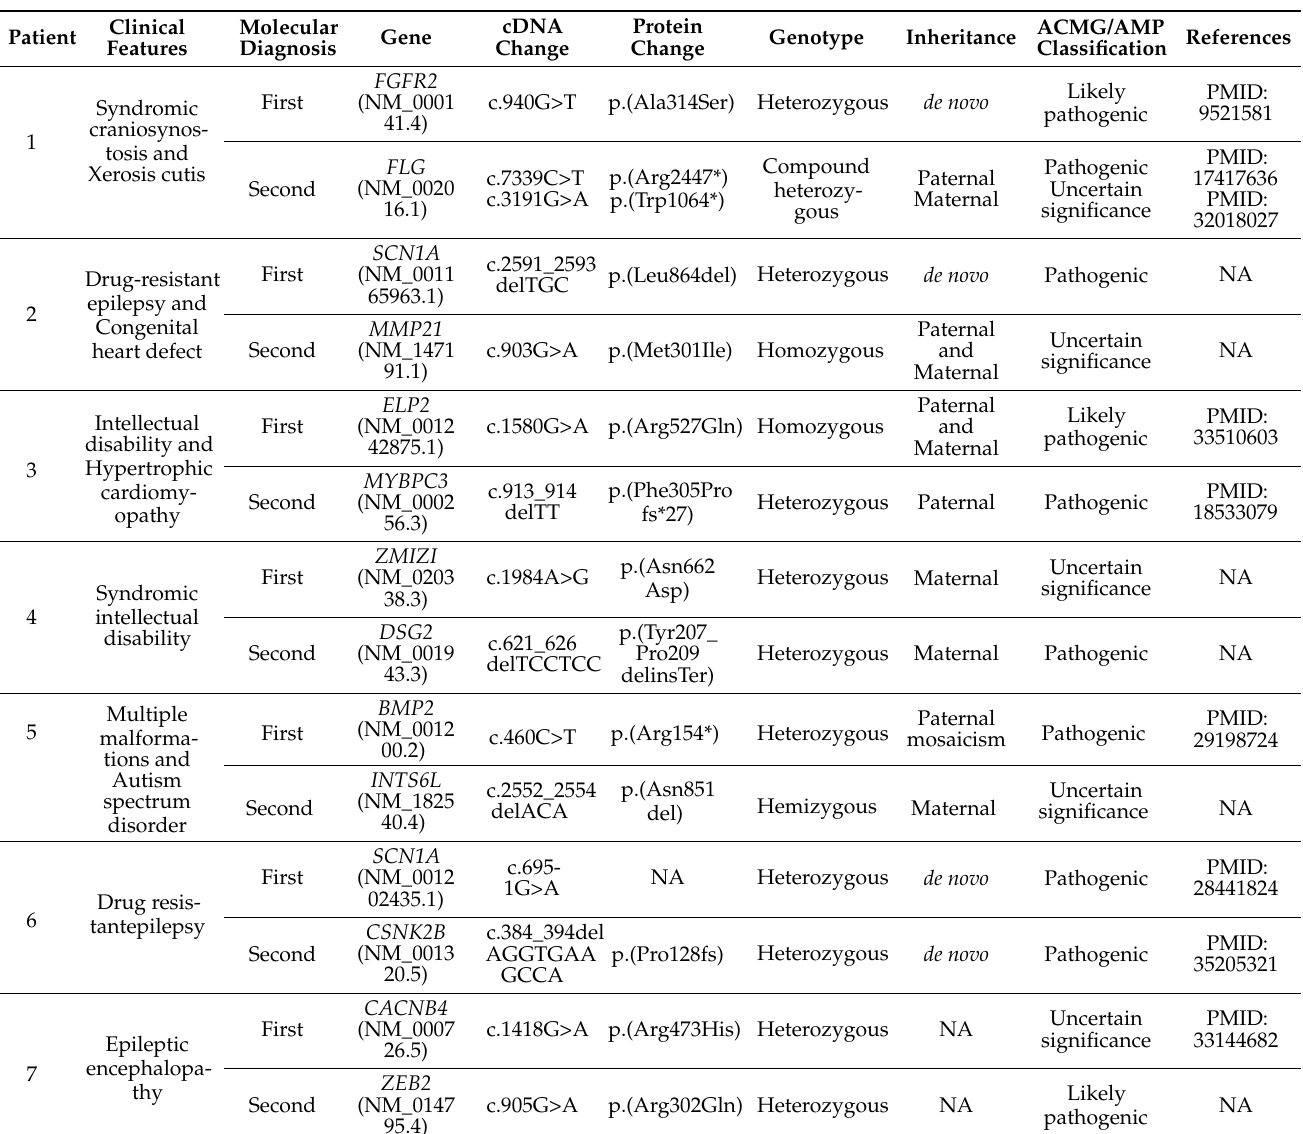
Table 1. List of dual molecular diagnoses identified through WES. Patient: Patients 1, 2, 3, 4 and 5 belong to group A (patients who present distinct phenotypes, due to each of the two different underlying genetic diseases), whereas Patients 6 and 7 belong to group B (patients with overlapping clinical features that may be underpinned by both the identified genetic variations). Clinical features: main characteristics displayed by each patient. Molecular diagnosis: the details of both genetic diagnoses are reported for every patient as follows: Gene: list of genes carrying the identified variants with NCBI RefSeq accession number of the considered protein-coding transcripts (NM_). cDNA change and Protein change: variant description according to the Human genome Variation Society (HGVS) nomenclature guidelines. Genotype: homozygous: the same variant is present on both alleles; heterozygous: the variant affects only one allele; compound heterozygous: two different variants are present on each allele; hemizygous: the variant affects a gene located on the X chromosome in a male subject. Inheritance: inheritance pattern of every identified variant established after parental segregation. ACMG/AMP classification: variants pathogenicity according to ACMG/AMP guidelines. References: PubMed unique IDentifier of publications reporting each variant. *: stop codon. NA: Not